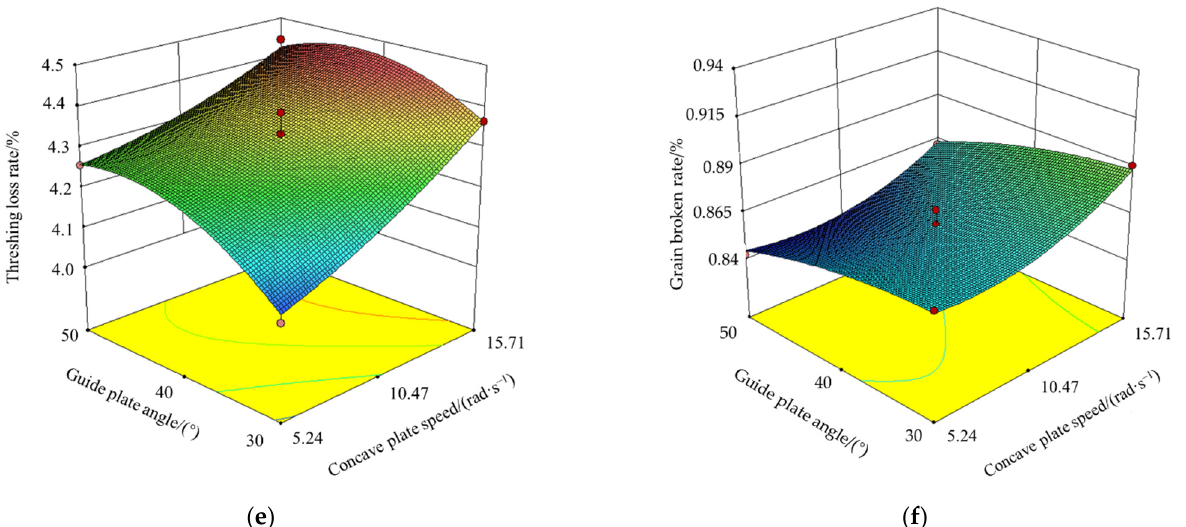
Figure 12. Influence of threshing device working parameters on threshing loss. ( a ) Influence of threshing cylinder speed and concave plate on threshing loss rate; ( b ) Influence of threshing cylinder speed and concave plate speed on grain breakage rate; ( c ) Influence of threshing cylinder speed and guide plate angle on threshing loss rate; ( d ) Influence of threshing cylinder speed and guide plate angle on grain breakage rate; ( e ) Influence of concave plate speed and guide plate angle on threshing loss rate; ( f ) Influence of concave plate speed and guide plate angle on grain breakage rate.